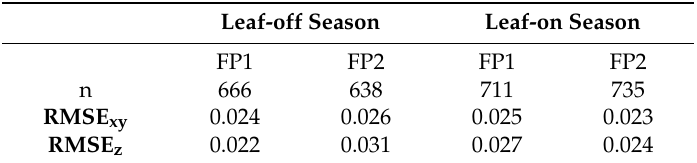
Table 1. Number of camera positions (n), root mean square horizontal and vertical errors in camera positions for GNSS PPK solution (in